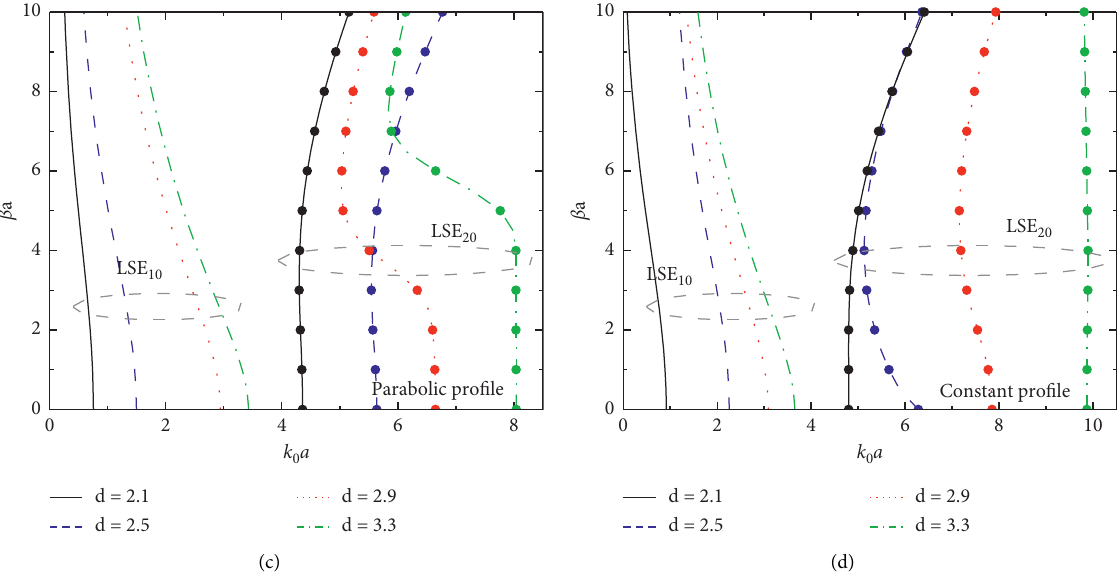
Figure 5: The dispersion relations of the LSE modes with various values of the profile parameter d and the step width of Δ d � 0 . 4: (a) exponential profile; (b) linear profile; (c) parabolic profile; (d) constant profile.